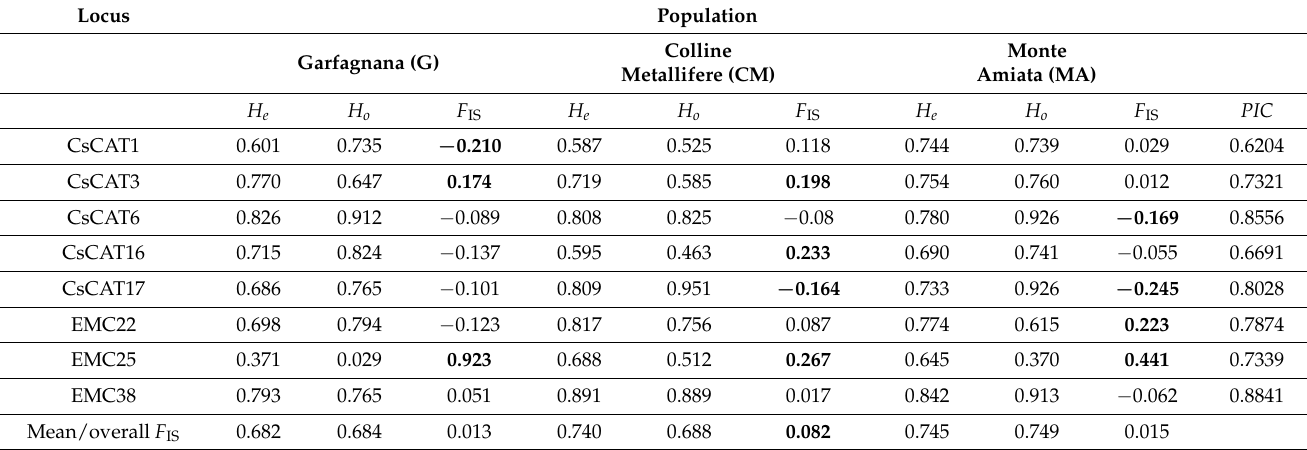
Table 2. Expected ( H e ) and observed ( H o ) heterozygosity are reported for each locus and each population, together with the mean across all loci. F IS is also reported for all loci and as an overall estimate for each population (last row). Values of F IS in bold are significantly different from zero ( p < 0.05), indicating Hardy–Weinberg